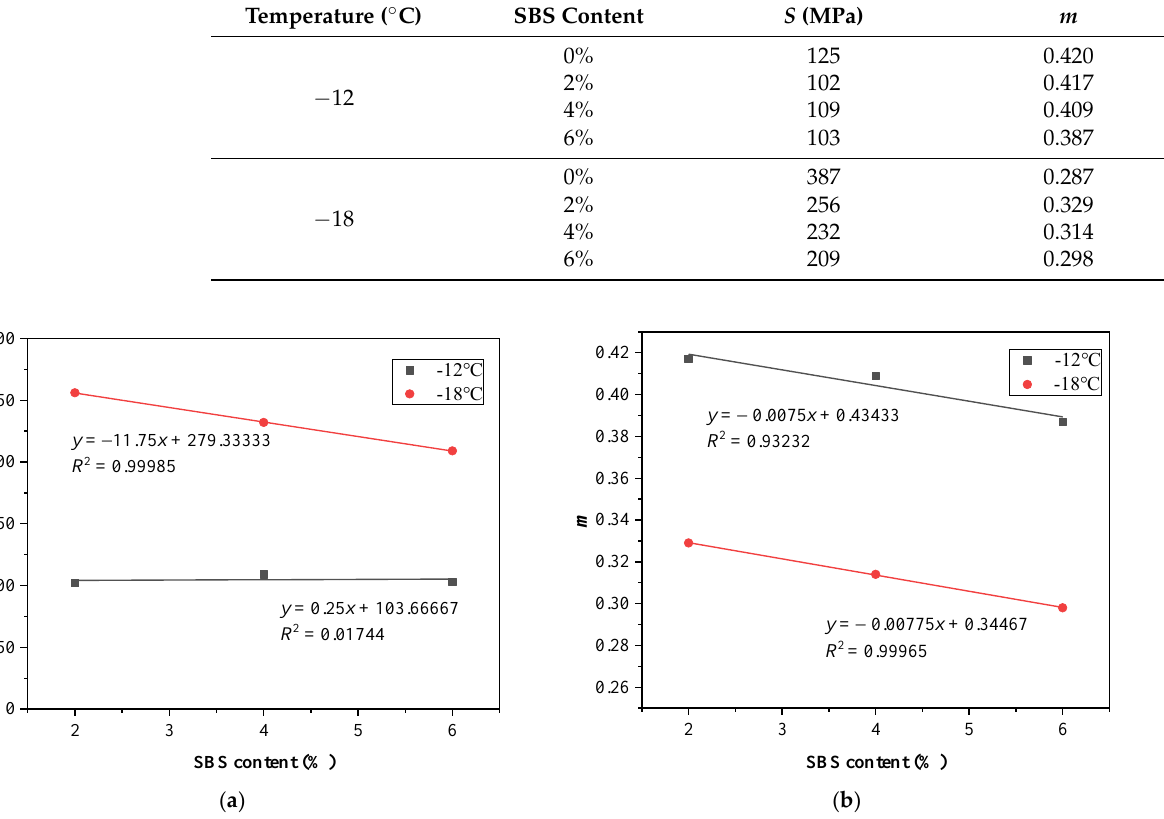
Figure 3. Calibration curves of SBS content based on ( a ) stiffness modulus S and ( b ) creep slope m.